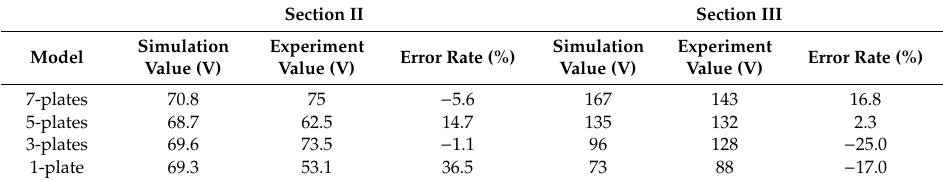
Table 2. Comparison of simulation and experiment voltage waveform.